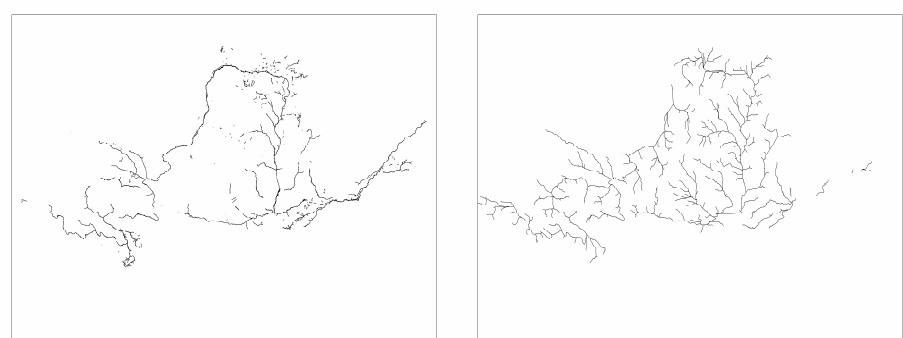
Figure 6. In the YRB, river in land use and the river under the optimal threshold. On the left are the rivers obtained from the land use data. On the right is the river network extracted with the threshold 126,590.